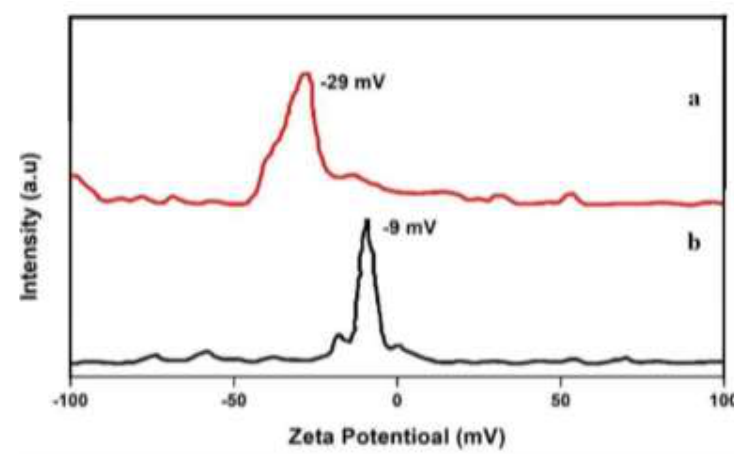
Figure 4: Zeta potential distributions curves for a) F-MWCNTS b)R-MWCNTS.